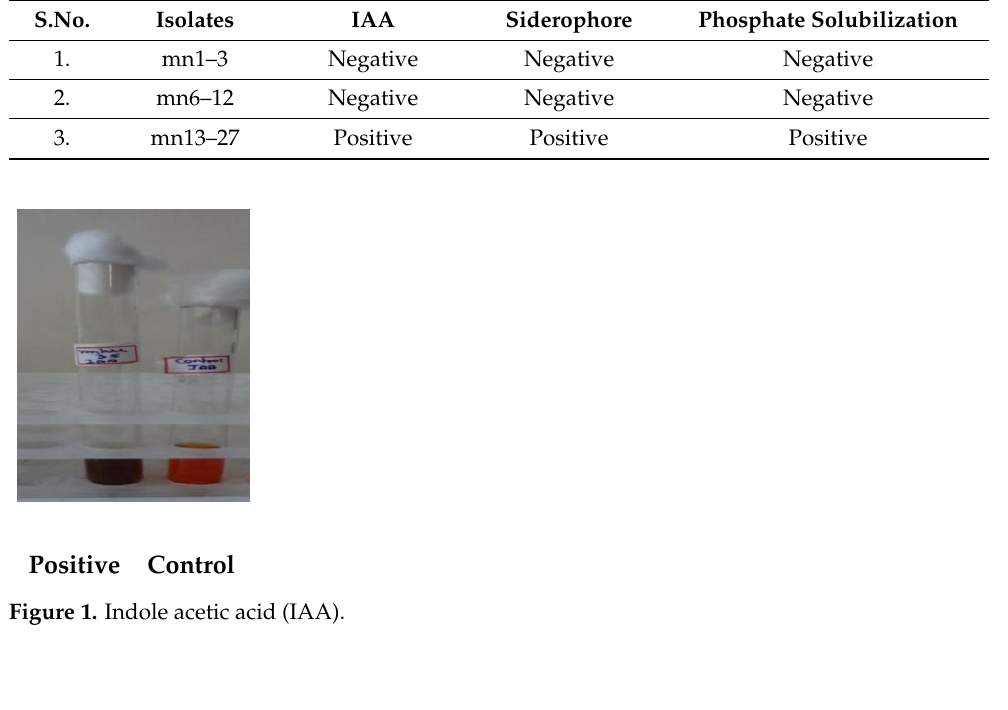
Table 1. Enzymatic characterization of the Bacillus isolates. S.No.